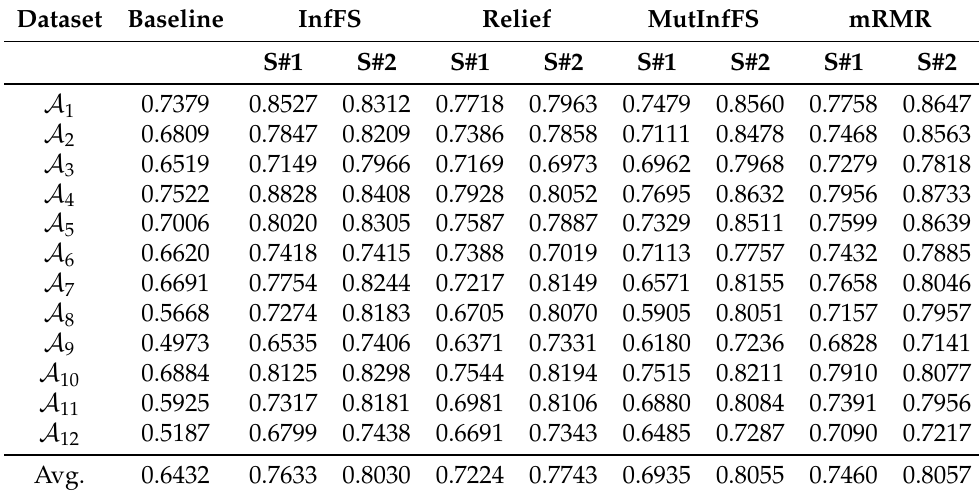
Table 1. The attained F-Measure (FM) values by means of the kNN classification model w.r.t. each